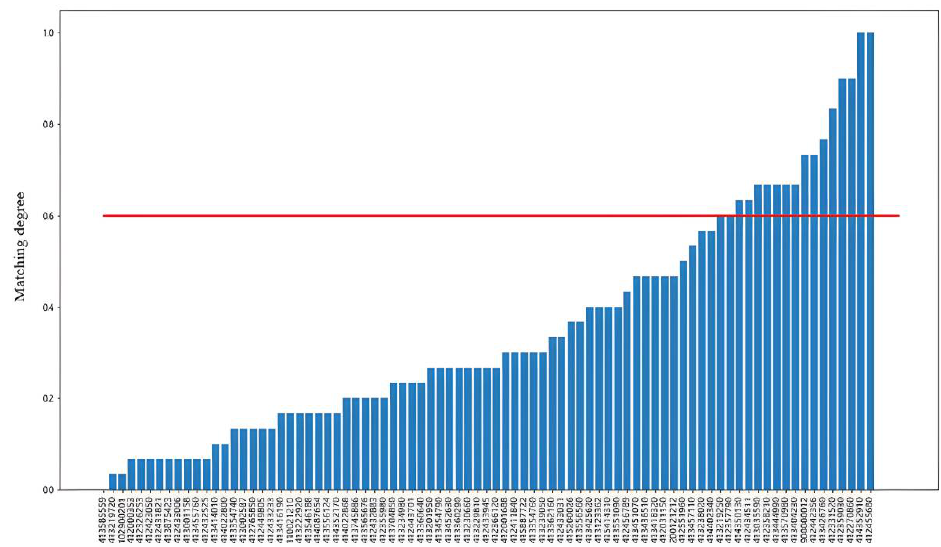
Figure 13. Histogram of the degree of matching of frequent behavioral patterns between the ships and the ship involved.